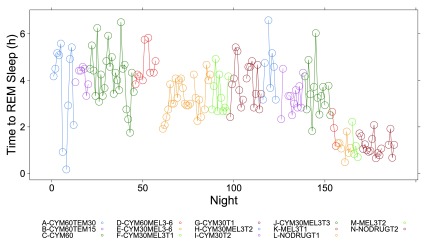
Time to REM sleep per night.The number of hours (h) per night before subject achieved first REM sleep bout during 5-minute intervals detected by the Zeo Sleep Monitor throughout the entire study. Dosages of Cymbalta (CYM60 = 60 mg, CYM30 = 30 mg), temazepam (TEM30 = 30 mg, TEM15 = 15 mg) and melatonin (MEL3 = 3 mg, MEL6 = 6 mg) were varied according to combinations A-N (T1, T2, T3 are trial replicates), including no drug trials (L, N).